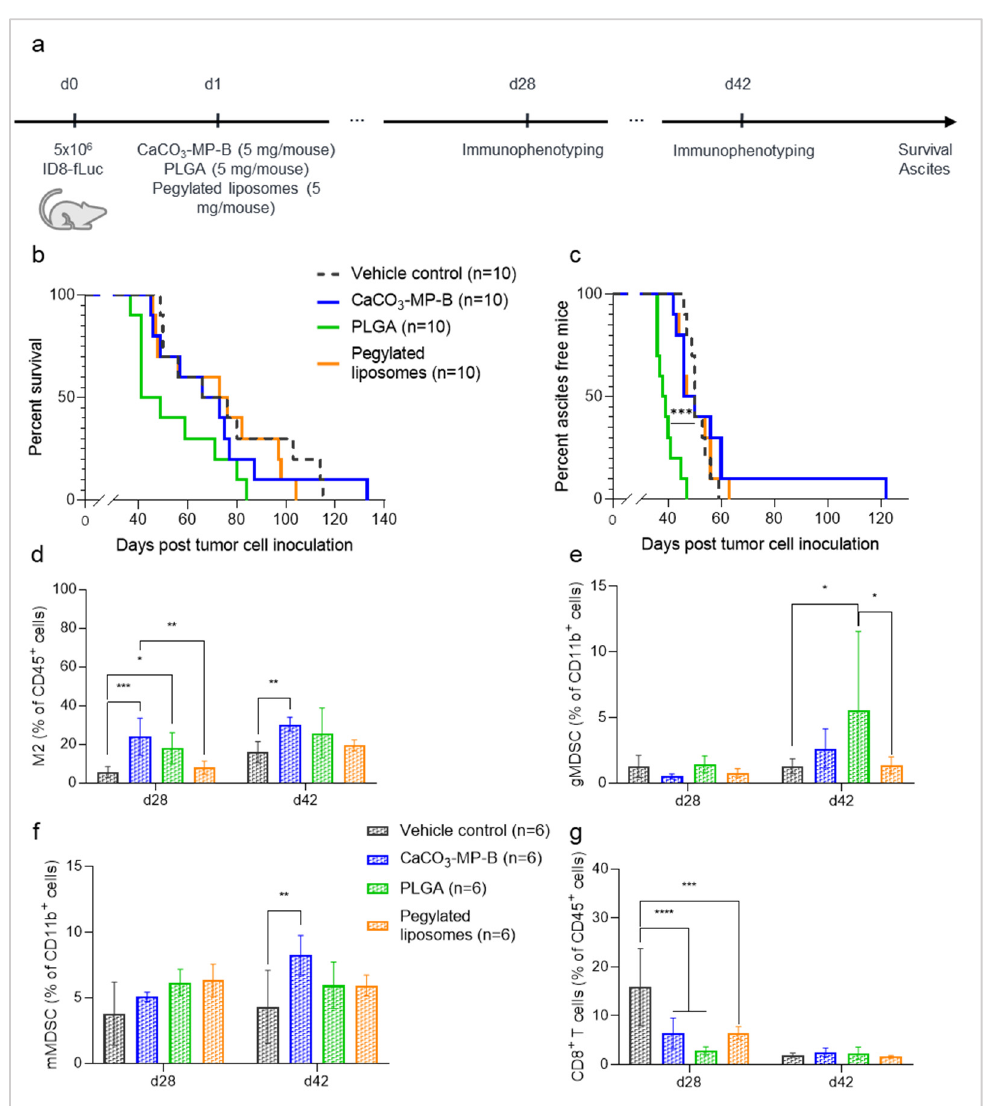
Figure 2. Experimental set-up of the experiment ( a ) with corresponding Kaplan–Meier curves for survival and time to ascites development ( b , c ) and immune profile of the tumor microenvironment on day 28 and 42 post tumor cell inoculation ( d – g ) of mice injected with vehicle control, 5 mg of CaCO 3 -MP-B, 5 mg PLGA or 5 mg pegylated liposomes. ( b ): No differences in survival were observed between the different groups. ( c ): Mice injected with PLGA did show a significant acceleration of ascites development compared with all other groups ( p adj = 0.0006). ( d – f ): In general, PLGA and CaCO 3 elicit a strong immune suppressive tumor microenvironment reflected by increases in M2 macrophages and MDSC, while pegylated liposomes have a more favorable innate immune profile. ( g ): The CD8 + T cells were suppressed by all three drug carriers. PLGA: polymer poly (lactic-co-glycolic acid), PLD: pegylated liposomal doxorubicin, MDSC: myeloid-derived suppressor cell. Degree of significance: p adj <0.05 (*), p adj < 0.01 (**), p adj < 0.001 (***), p adj < 0.0001 (****).